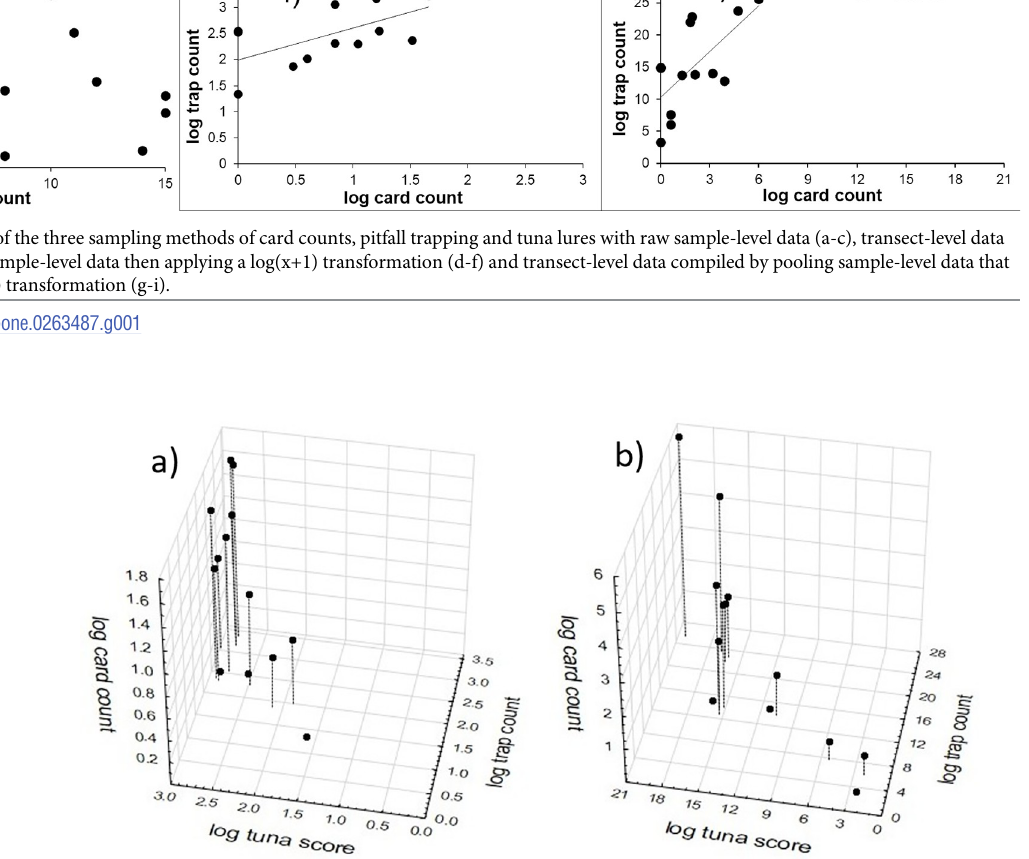
PLOS ONE | https://doi.org/10.1371/journal.pone.0263487 June 15,